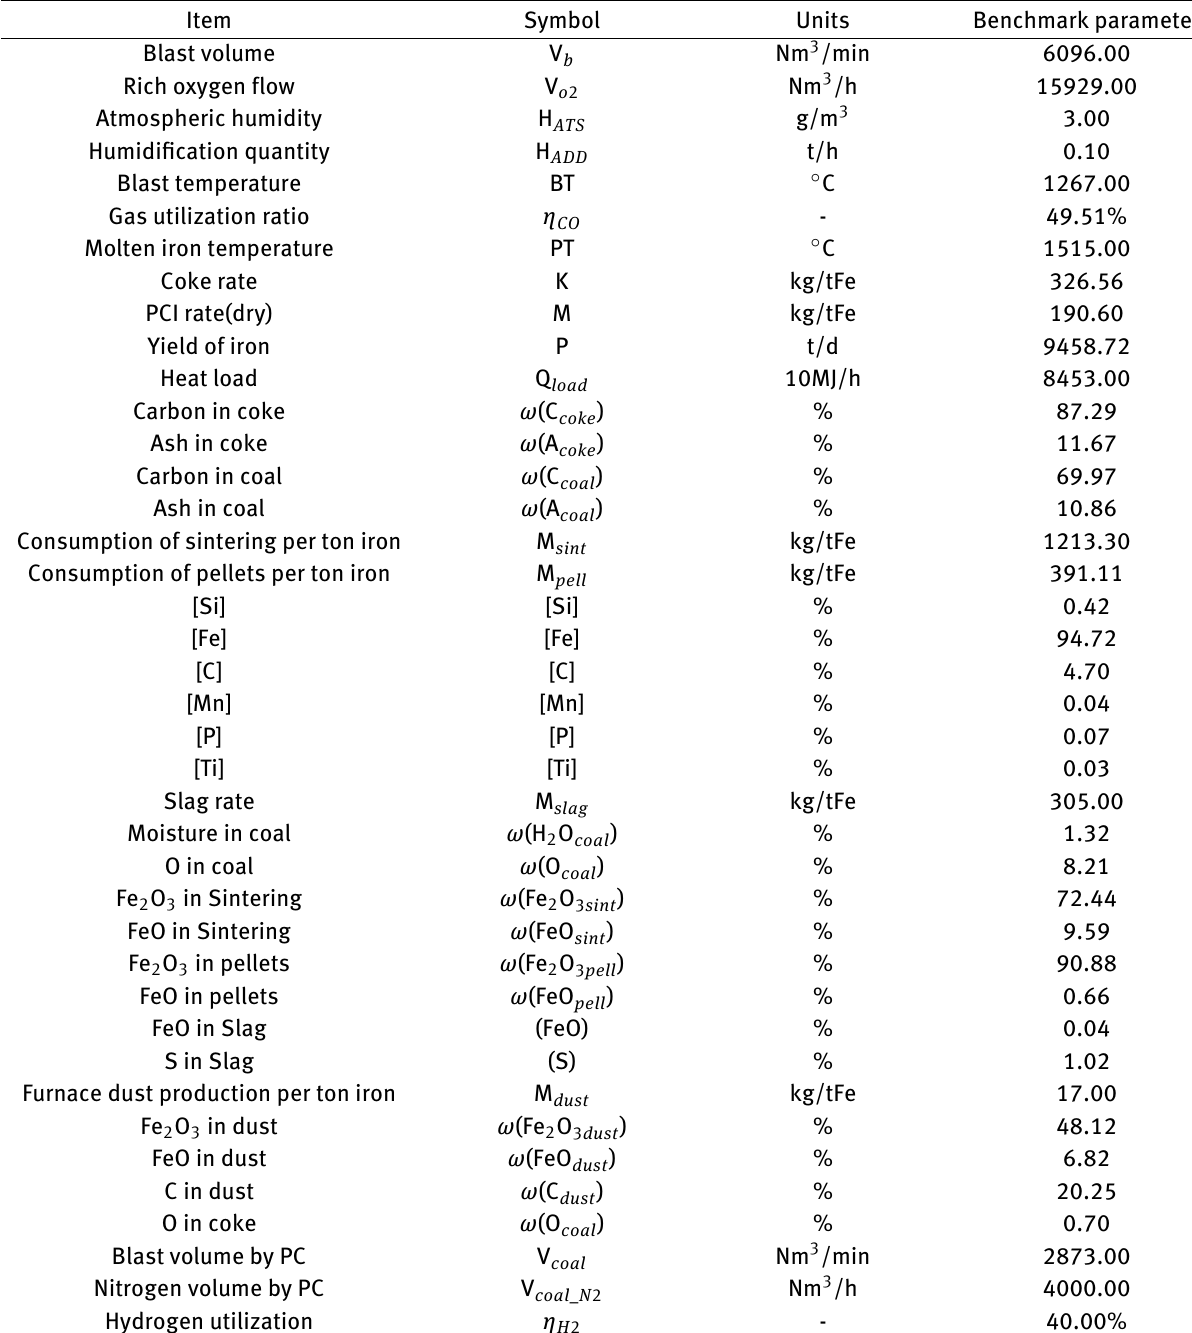
Table 1: Benchmark parameters of blast furnace. Item